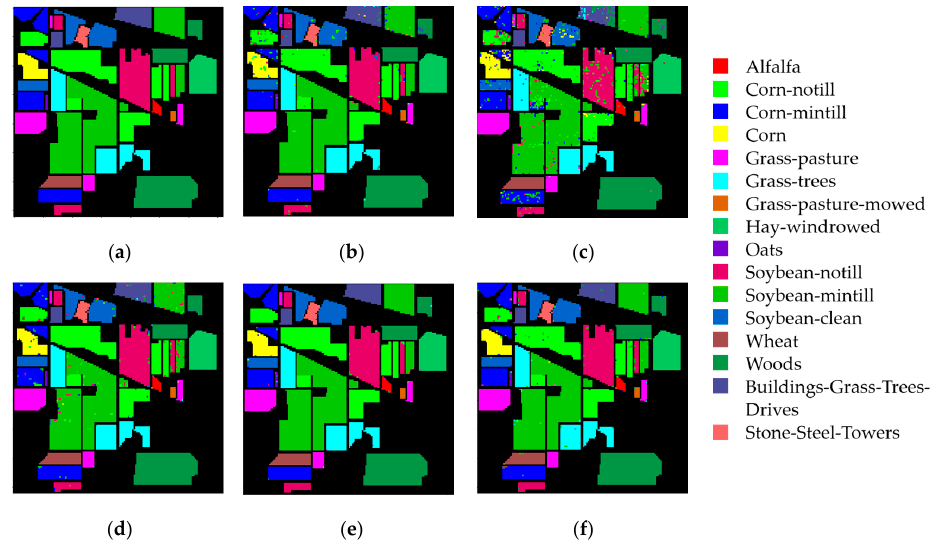
Figure 7. The classification map for Indian Pines dataset of different networks. ( a ) ground truth; ( b ) SAE (OA: 96.02%); ( c ) 1D-CNN (OA: 88.34%); ( d ) 3D-CNN (OA: 95.52%); ( e ) DC-CNN (OA: 99.11%); ( f ) S2FEF-CNN (OA: 97.43%).